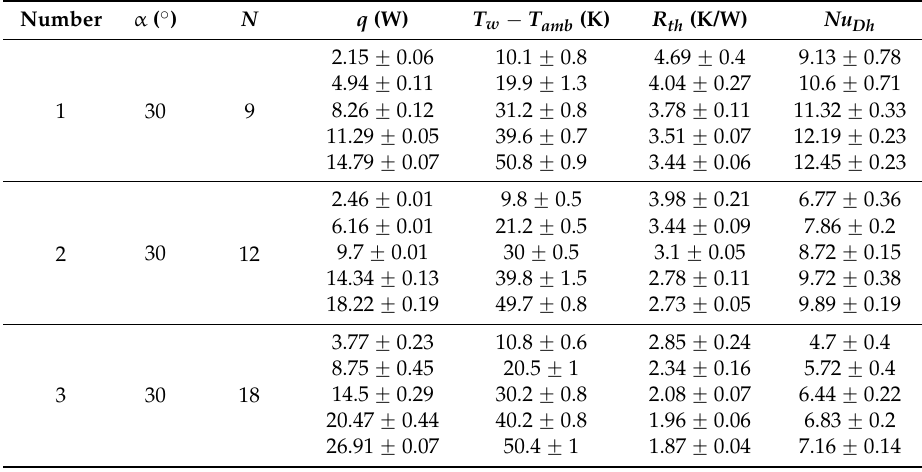
Table 2. Thermal resistances and Nusselt numbers calculated from experimental data.